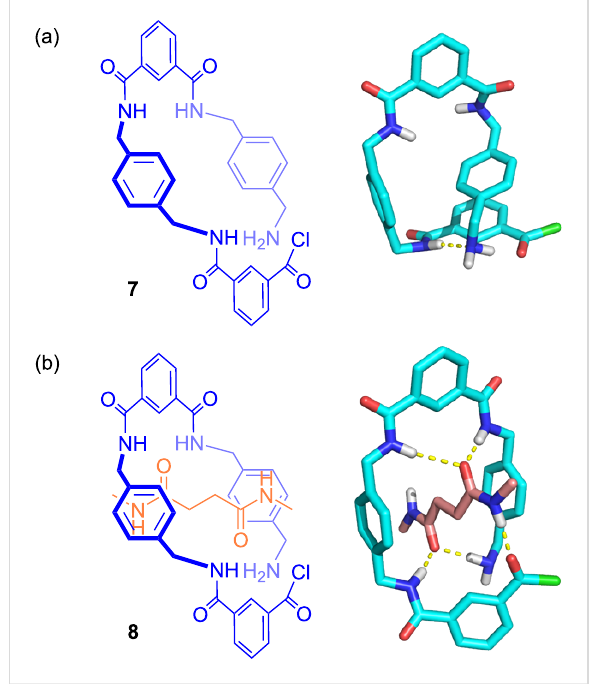
Figure 3: Most stable conformers obtained by Monte Carlo conforma- tional search using model compounds. (a) Model macrocyclization reaction intermediate in the absence of a template; (b) model macrocy- clization reaction intermediate in the presence of a template.